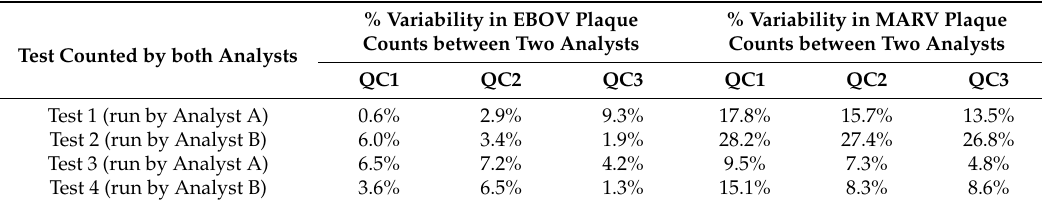
Table 4. Variability in counts measured by two analysts is minimal for the EBOV and MARV plaque